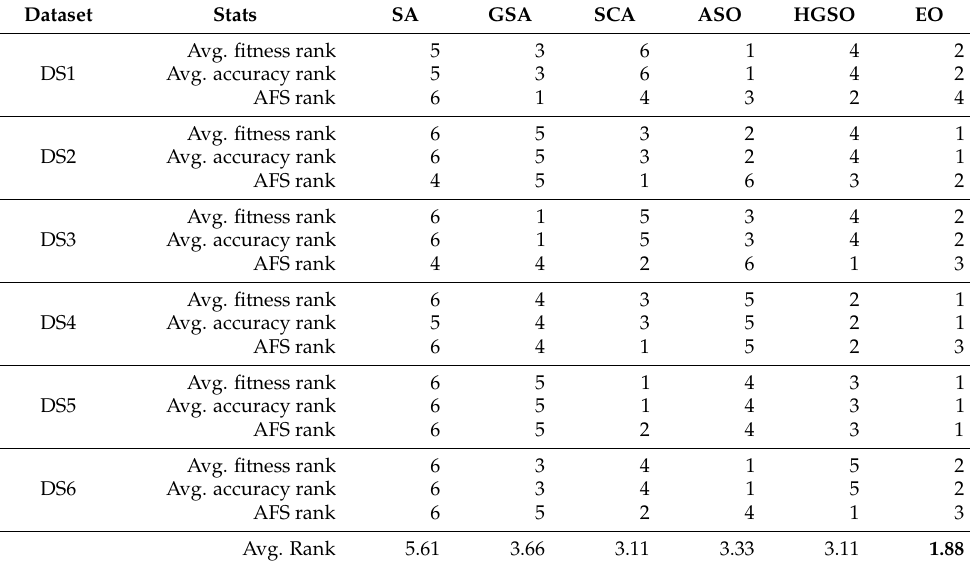
Table 6. Average rank of all averages (Fitness, accuracy, and